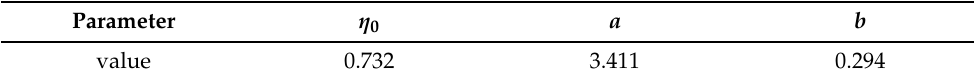
Table 1. List of parameters related to flat plate solar collector [19]. Parameter η